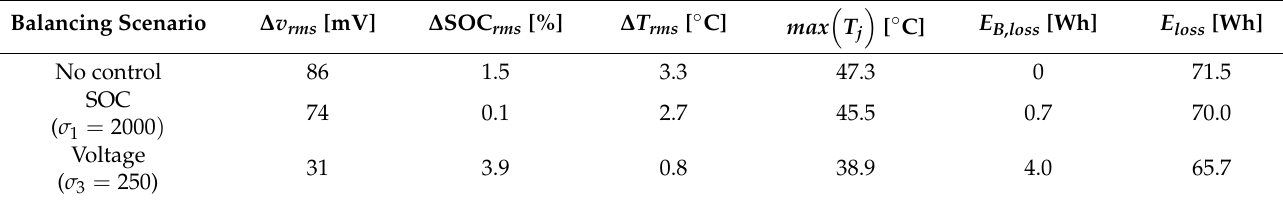
Figure 17. Single controllers results in time. Scenario: fast charging, mixed aging, parallel forced air cooling ( h = 15 W/m 2 K). All cases using the CP-CV charge profile of the ‘no control’ case. Table 6. Key metrics of single controllers results shown in Figure